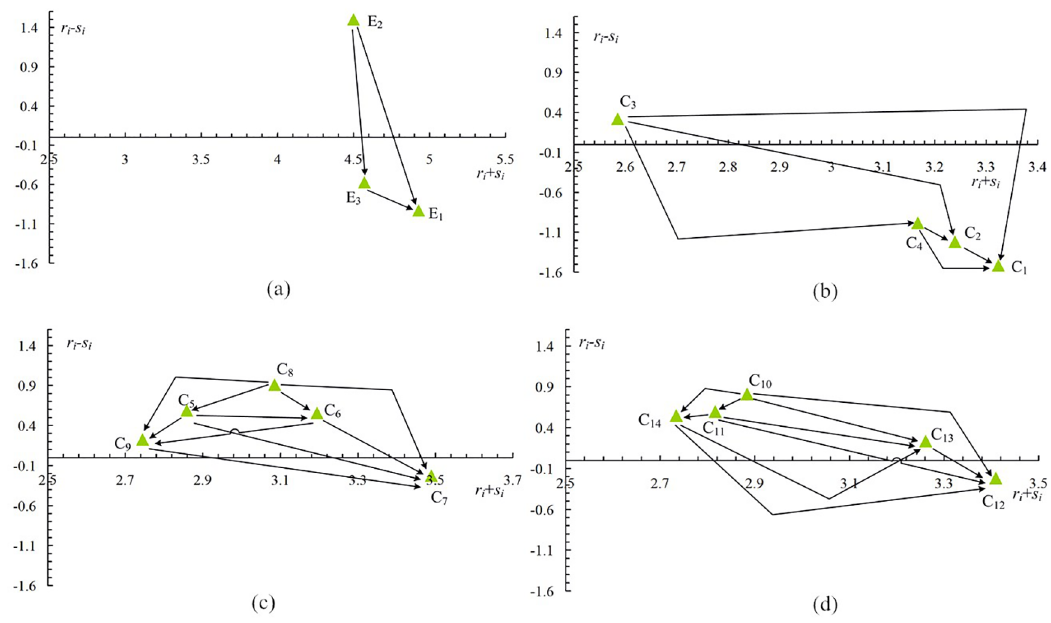
Fig 2. Causal influence diagrams for the dimensions and